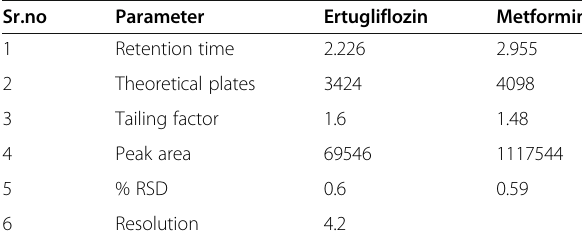
Table 1 System suitability parameters for Metformin and Ertugliflozin